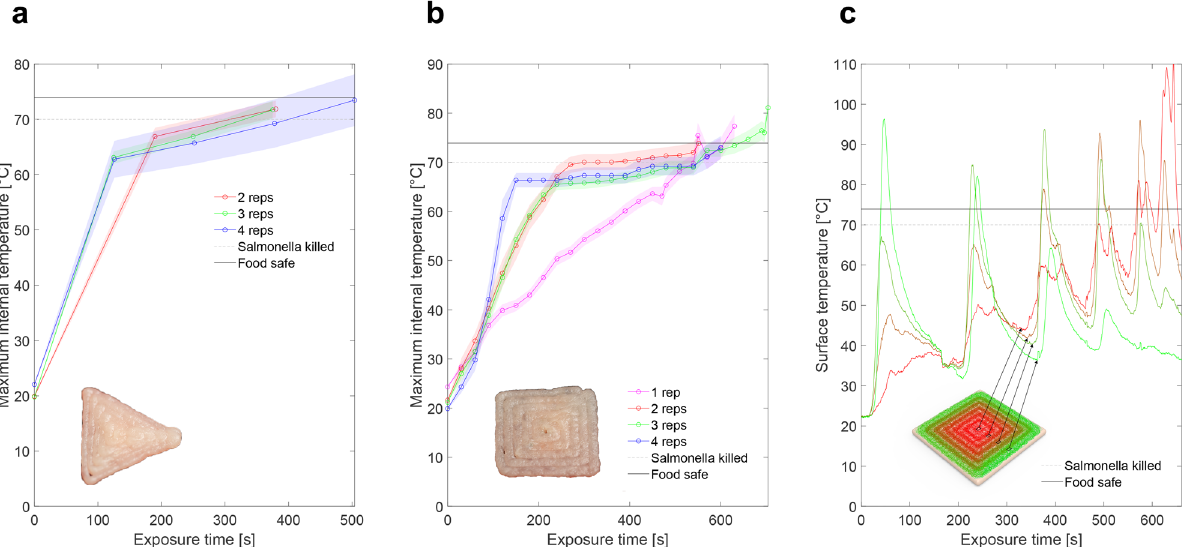
Fig. 3 Temperature progression during cooking (each line represents a single test). a Maximum internal temperature achieved for triangular printed samples at various repetitions (shaded region for each line shows standard error from four thermocouples of a single sample). b Maximum internal temperature achieved for square printed samples at various repetitions (shaded region for each line shows standard error from four thermocouples of a single sample). c Surface temperature of four different voxels of chicken on the same heat- affected sample for a single rep cooking cycle. The curves range in color from green (voxel along the edge of sample) to red (voxel in the center), as does the graphic of the cooking pattern used which starts along the edge (green) and spirals in toward the center (red) of the